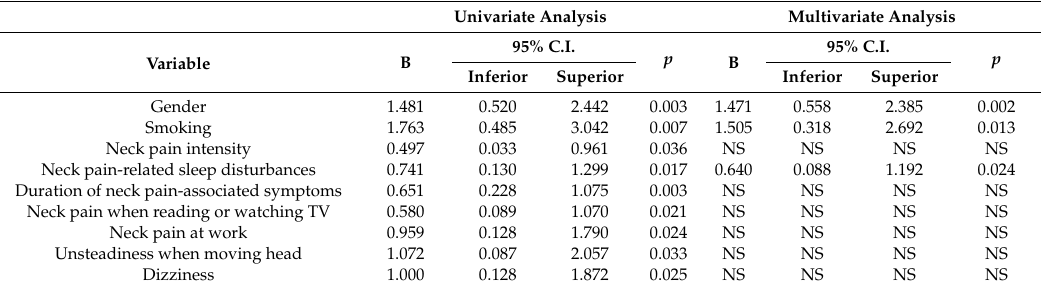
Table 5. Univariate and multivariate lineal regression to analyze the factors related to the intensity of